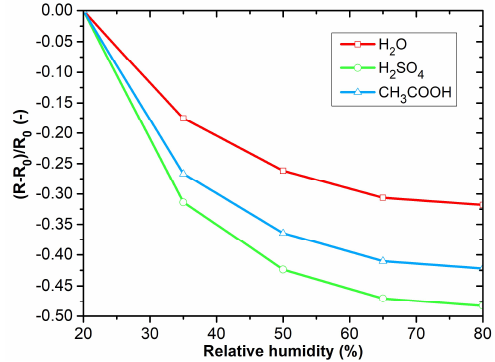
Figure 11. RH dependences of active layers .